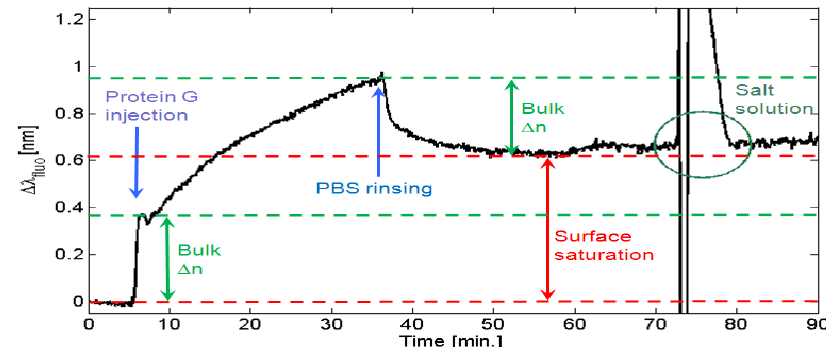
Figure 6. Real-time sensorgram showing the covalent binding of protein G onto the functional polymeric film during incubation in PBS